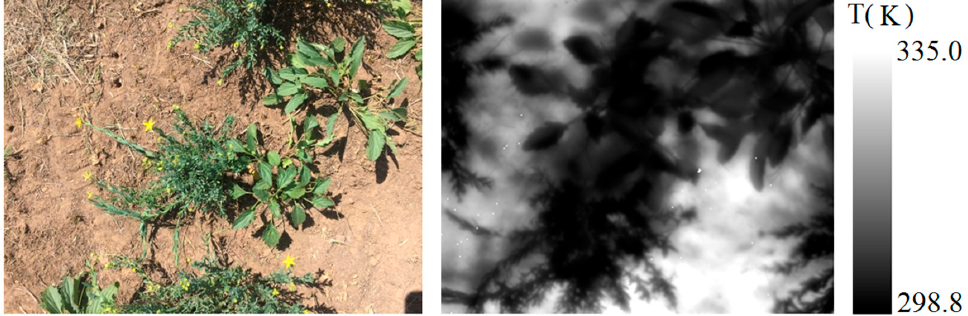
Figure 17. Temperature of Potentilla chinensis .